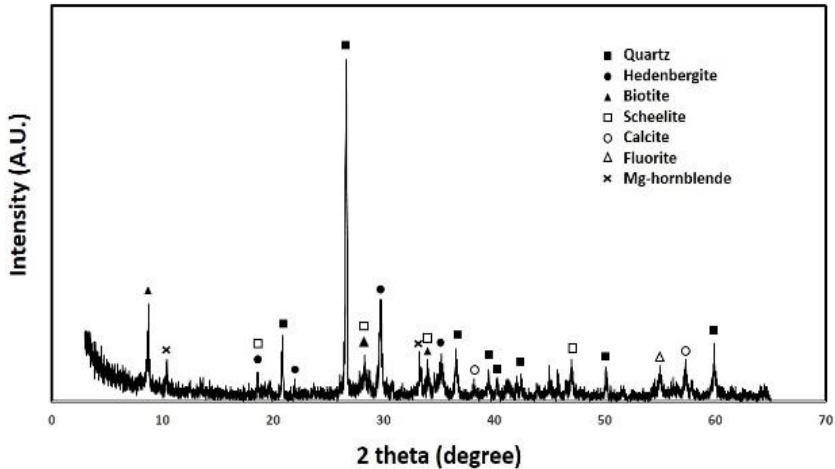
Figure 4. X-ray powder di ff raction patterns of the run-of-mine tungsten ore from the Sangdong mine in South Korea .